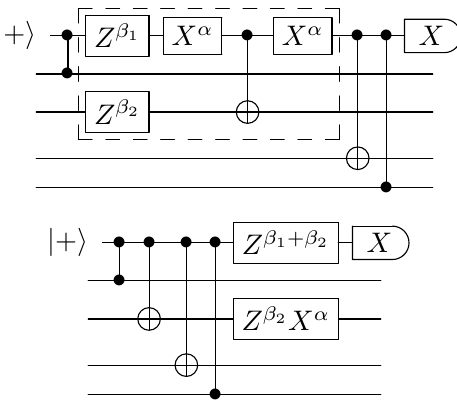
FIG. 3. Randomizing a single CX c , t gate in a circuit that mea- sures the stabilizer of the XZZX code, where c denotes the control qubit and t the target. Rather than apply the bare CX c , t gate, we randomly insert an element of Z 2 before the gate and randomly apply either CX c , t or X c CX c , t X c . This modification of the circuit results in an overall Pauli operator, which can be tracked in